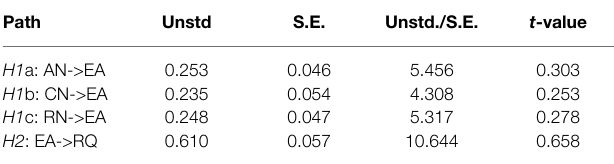
TABLE 5 | The analysis of regression coefficient.